Question: What caption would you write for this figure?
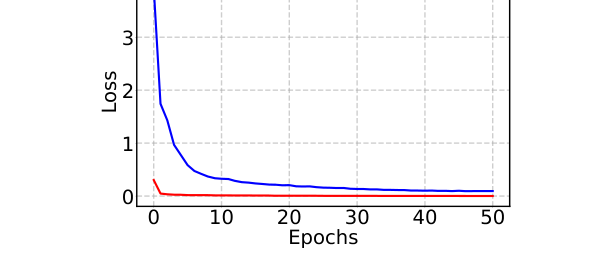
Answer: Training loss of a d-Simplex fixed classifier during a model update. Values are the cross-entropy loss of Eq. 2 (red line) and the loss of Eq. 3 (blue line). Models are trained on MNIST.